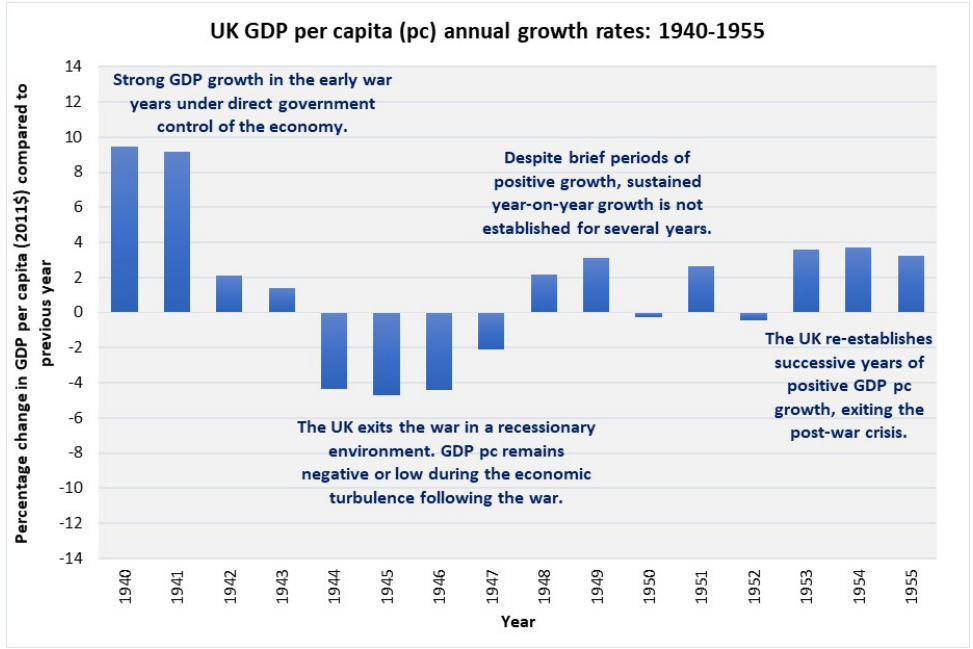
Figure 2. Annual growth rates as the UK exited the Second World War and regained sustained growth after several years of crisis (see Note